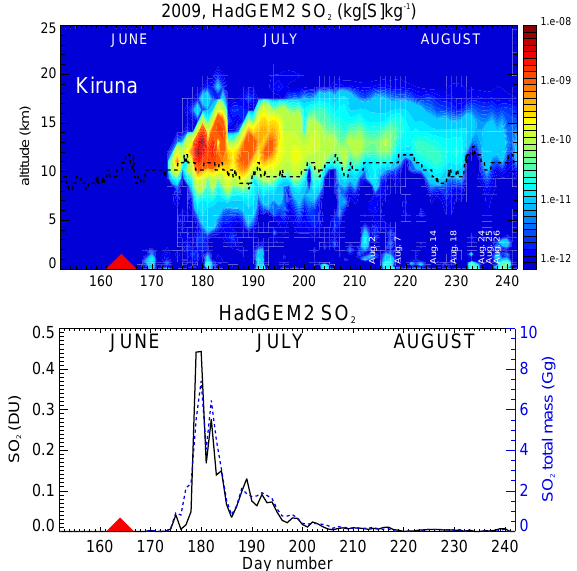
Fig.3. SO 2 dailyevolutionoverKirunafromJunetoAugust2009modelledbytheHadGEM2climatemodelfromsurfaceto25km(top) Fig. 3. SO 2 daily evolution over Kiruna from June to August and inverticallyintegratedcolumns (bottom)overKirunainDU(blackline)andovera ± 10˚lat-lonboxcentred overKirunainGg(blue dashedline).ThedatesoftheSTACflightsareindicatedinwhiteintheupperpanel. Theblackdashedlineisthemodelthermaltropopause. 2009 modelled by the HadGEM2 climate model from the surface TheSarycheveruptionissymbolizedbytheredtriangle. to 25km (top) and in vertically integrated columns (bottom) over Kiruna in DU (black line) and over a ± 10 ◦ lat–long box centred over Kiruna in Gg (blue dashed line). The dates of the STAC flights in August are indicated in white in the upper panel. The black dashed line is the model thermal tropopause. The Sarychev erup- tion is symbolized by the red